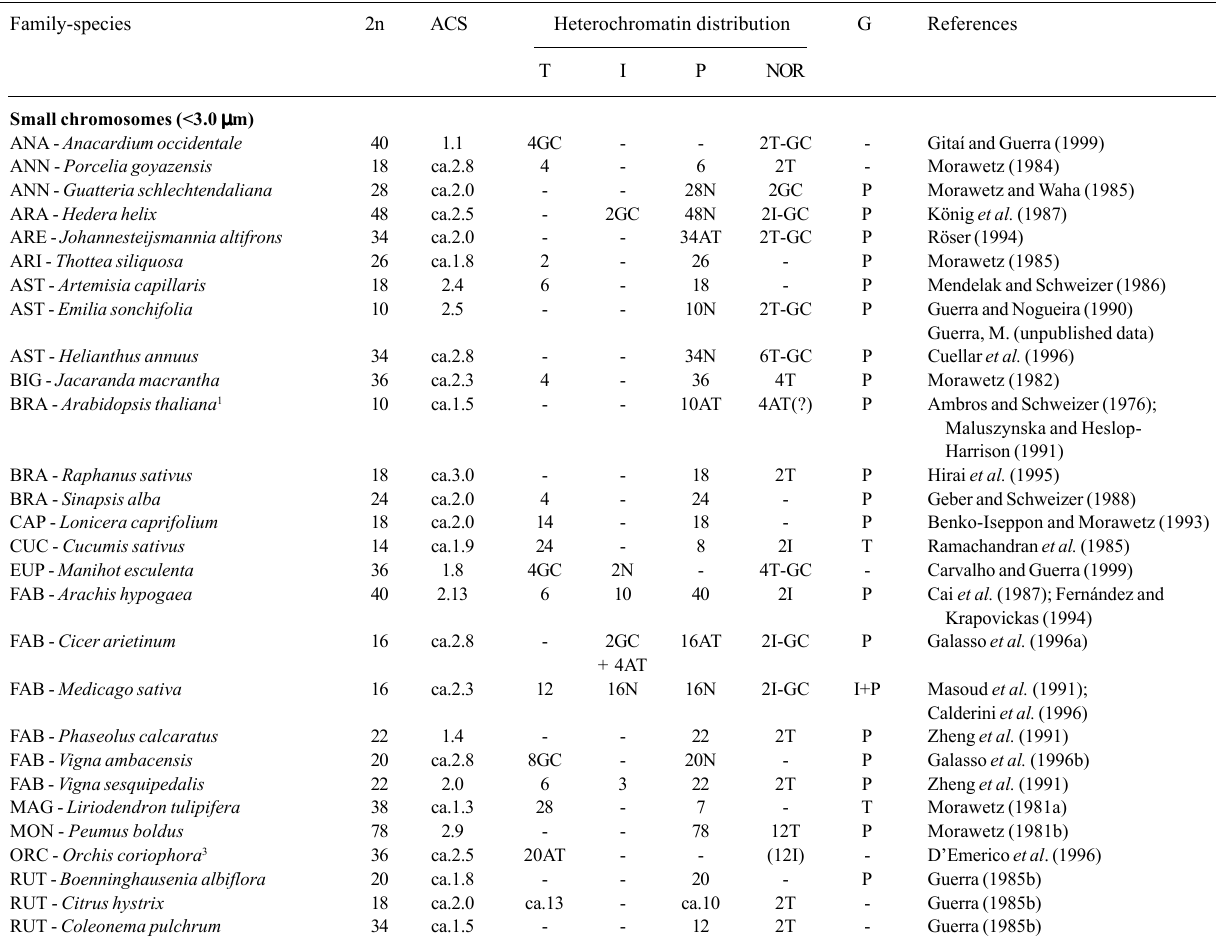
Table I - C-band distribution in plant karyotypes with small, medium and large average chromosome size (ACS). Generalized bands (G) may be located at the telomeric (T), interstitial (I) and proximal (P) regions. Family names are indicated by the three first letters (ANA = Anacardiaceae, ANN = Annonaceae, etc). Numbers after species names identify the fluorochromes used: 1, DAPI; 2, quinacrine; 3, Hoechst 33258; 4, CMA. Heterochromatin with main base composition identified but without any indication of fluorochrome used was stained with CMA/DAPI. NOR associated bands are identified by number, position (T, I or P), and AT or GC richness; base composition not defined = ?; number in brackets are NOR sites without C-bands. Estimated values are indicated by ca. (circa).